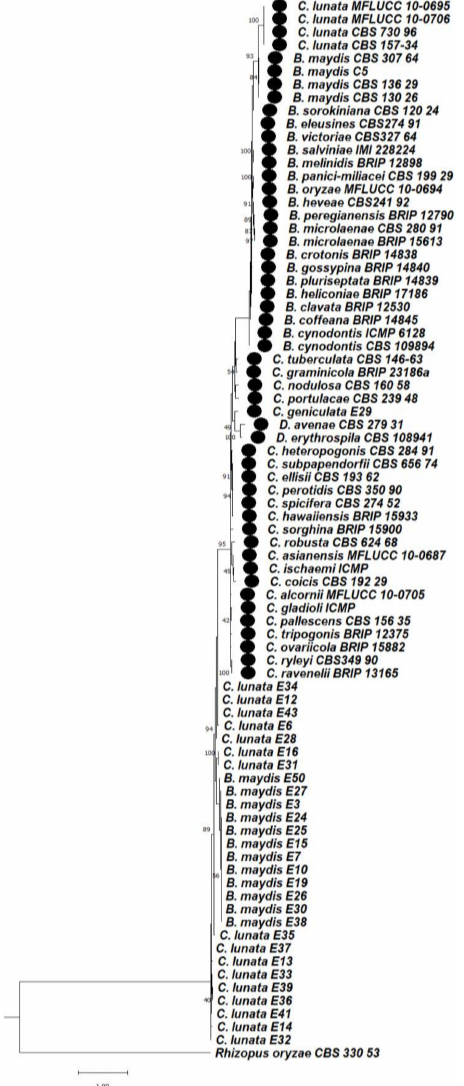
Figure 11. Maximum likelihood phylogeny based on combined internal transcribed spacer (ITS), large subunit gene regions (LSU), and glyceraldehyde-3-phosphate dehydrogenase (GAPDH). Se- quenced data of the Bipolaris maydis and Curvularia lunata isolates were inferred with Raxml based on GTR + Gamma model. Numerical value presented in the node indicates bootstrap value with a 1000 non-parametric bootstrap replicate analysis. Drechslera avenae CBS 279.31, Drechslera erythospila (sexual stage- Pyrenophora erythospila) CBS 108,941 were used as other genera from Helminthosporoid group. The symbol • denotes as ‘ ex-type ’ 43 closely related species sequences obtained from GenBank. Rhizopus oryzae used as an